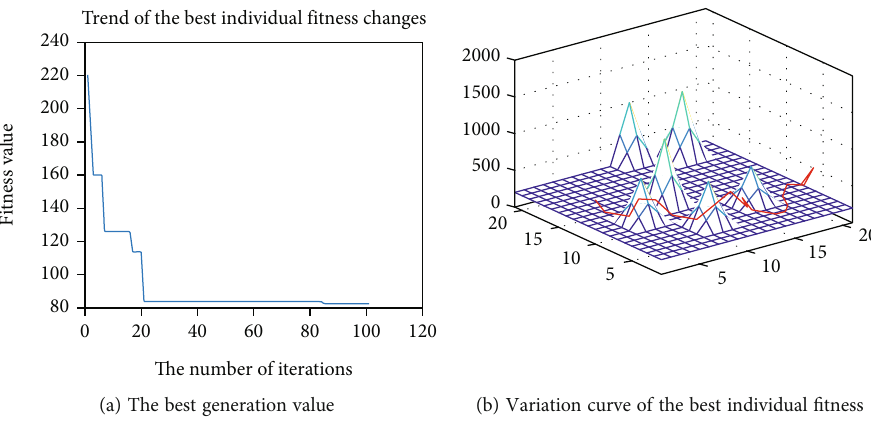
Figure 8: End two: the best generation value and path planning curve.